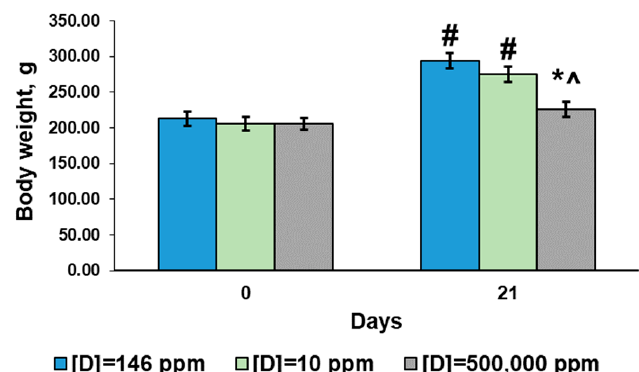
Figure 1. Body weight of the rats that consumed water with modified deuterium content for 21 days. Data are shown as mean ± S.E.M.; p < 0.05 compared to the control (*), to the rats that consumed water with [D] = 10 ppm (^), and to the initial weight (#).